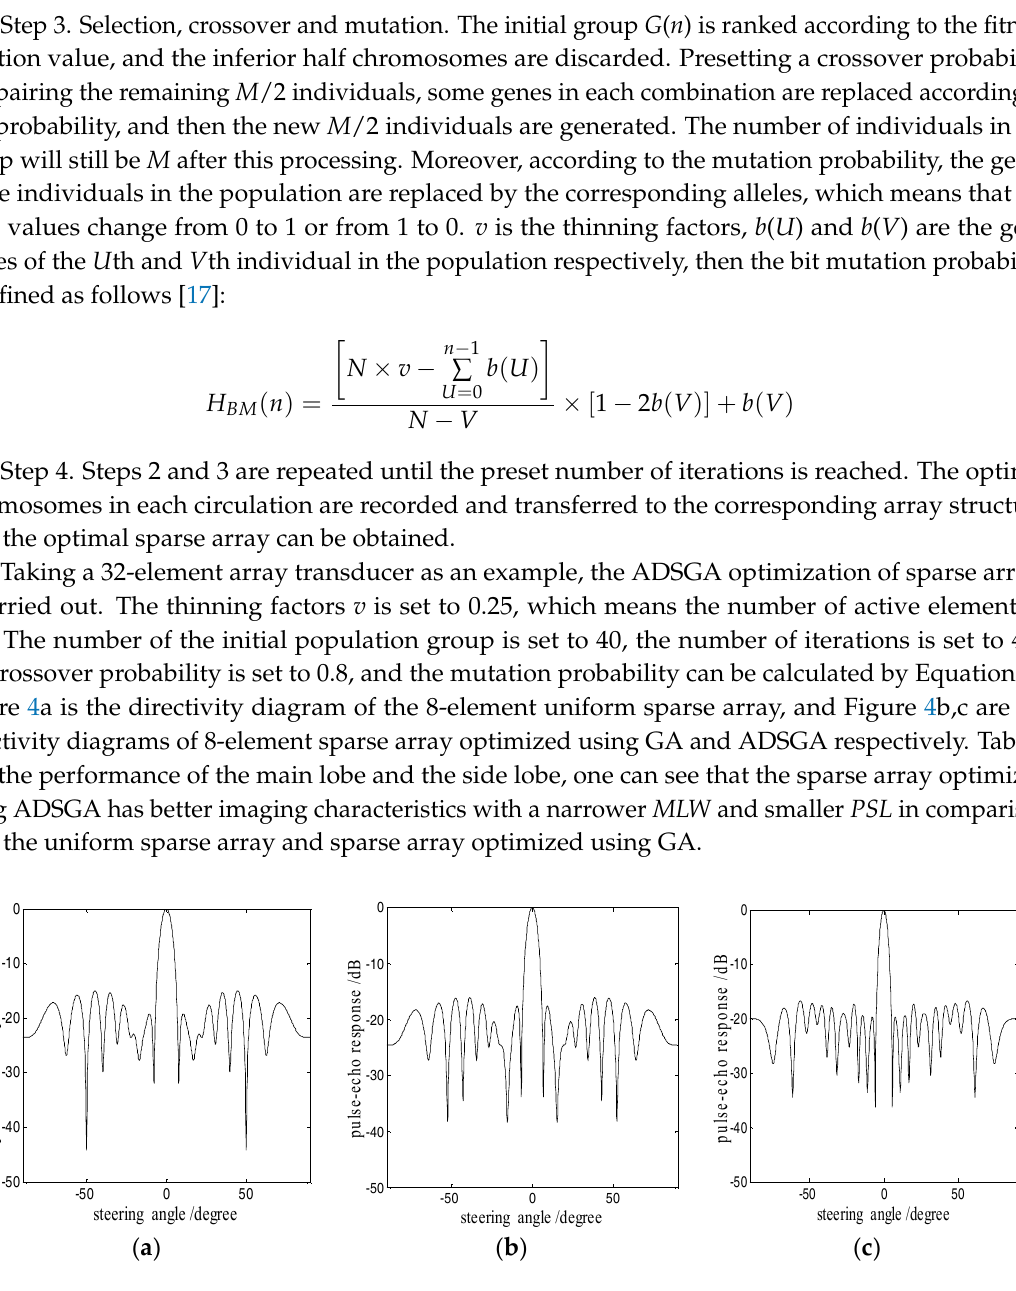
Figure 4. Directivity diagrams of the 8-element sparse arrays: ( a ) uniform; ( b ) GA; and ( c ) ADSGA. Table 1. Performance of the 8-element sparse arrays.